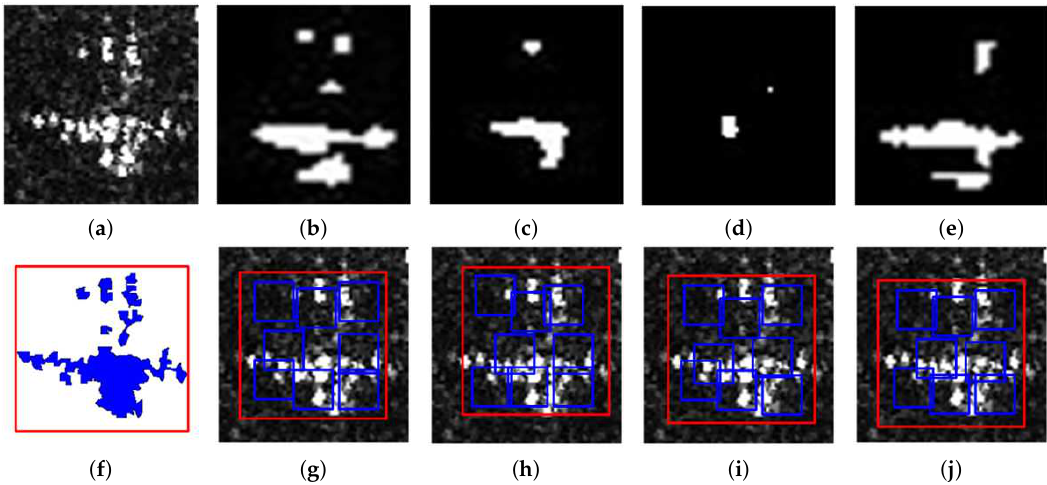
Figure 5. Target detection results of the CFAR and SDMC model based on four different statistical distributions. ( a ) original image; ( b ) Gamma distribution; ( c ) Rayleigh distribution; ( d ) Log-Normal distribution; ( e ) Weibull distribution; ( f ) ground truth; ( g ) Gamma SDMC model; ( h ) Rayleigh SDMC model; ( i ) Log-Normal SDMC model; and ( j ) Weibull SDMC model.